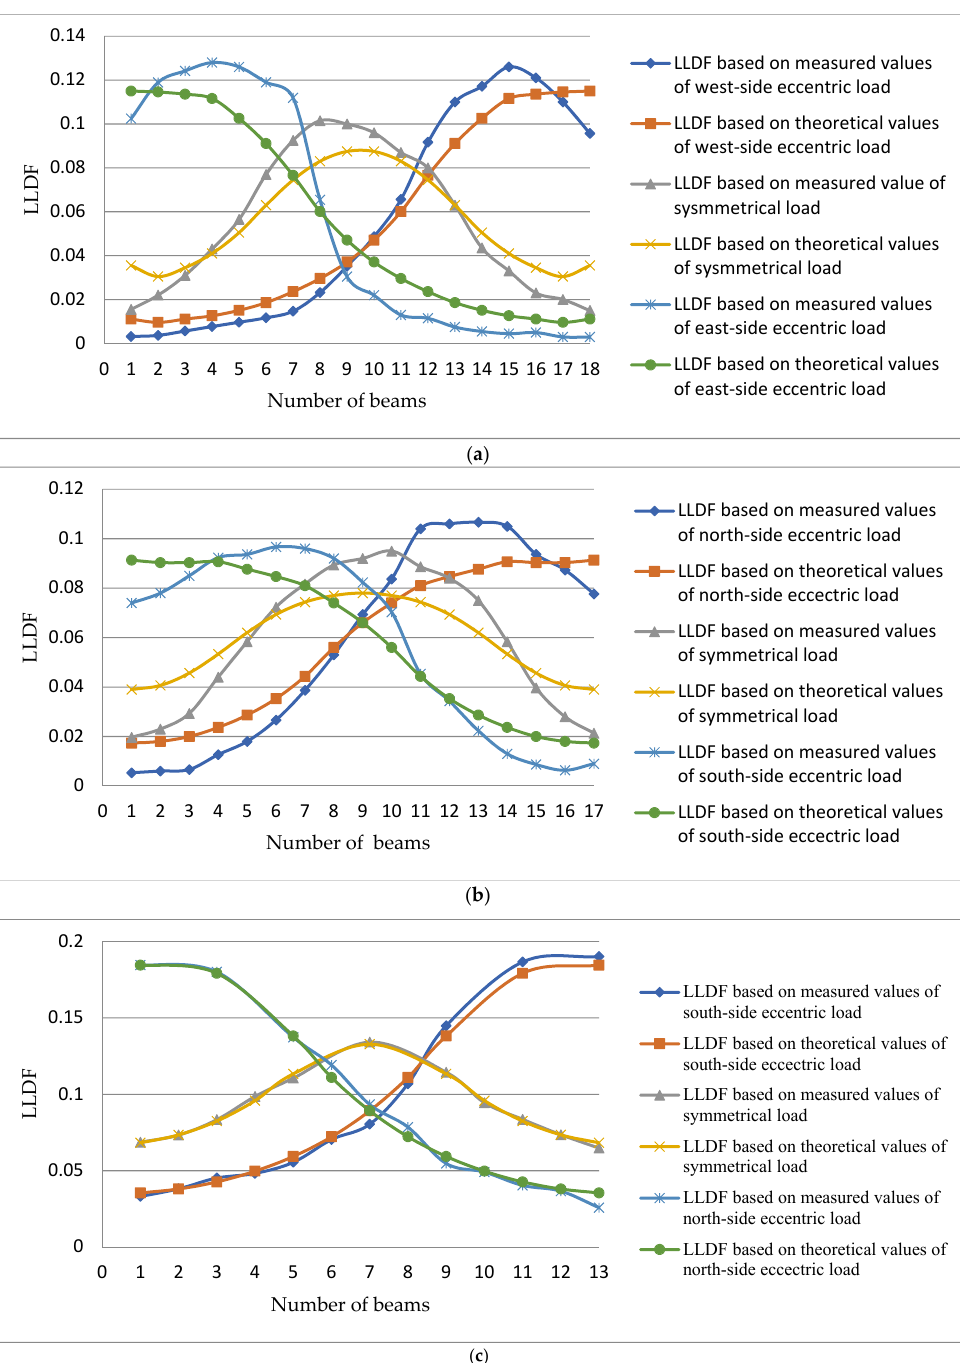
Figure 6. ( a ) Lateral deflection influence lines of Changhong Tunnel K1 + 812 Bridge (13 m span). ( b ) Lateral deflection influence lines of Baidong No. 2 Bridge. ( c ) Lateral deflection influence lines of Yunhe Bridge. Table 7. 𝑉𝐷 (cid:3039)(cid:3031)(cid:3033) of Changhong Tunnel K1 + 812 Bridge, Baidong No. 2 Bridge, and Yunhe Bridge.